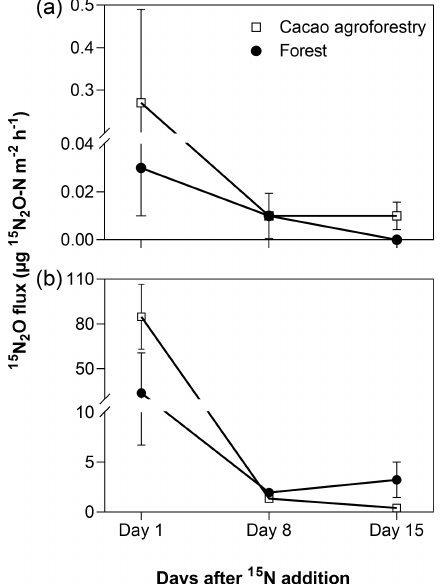
Figure 3. Mean ( ± SE, n = 3) 15 N 2 O fluxes from stems ( a , unit is per square metre of stem area) and soil ( b , unit is per square me- tre of ground area) in the Congo Basin, Cameroon. In May 2018, 290mg 15 N (in the form of ( 15 NH 4 ) 2 SO 4 with 98% 15 N) was dis- solved in 8L distilled water and sprayed within a 0.8m 2 area around each tree (equal to 10mm rain), which was only 20% of the extant mineral N in the top 10cm of soil and 49 ± 1% and 52 ± 2% water- filled pore space for the forest and CAF, respectively, comparable to the soil water content of the site (Fig.